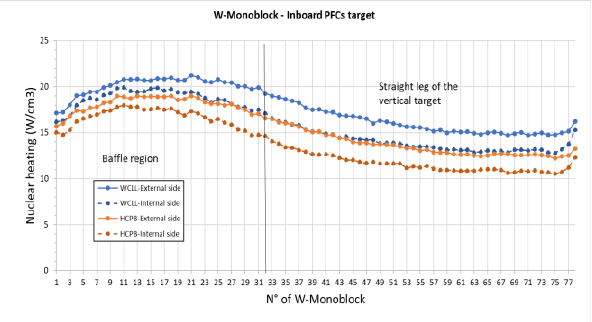
Figure 32. Inner poloidal profiles of the nuclear heating (W/cm 3 ) on W-Monoblocks, comparing the values on the external and the innermost target sides, both for WCLL and HCPB blanket case.